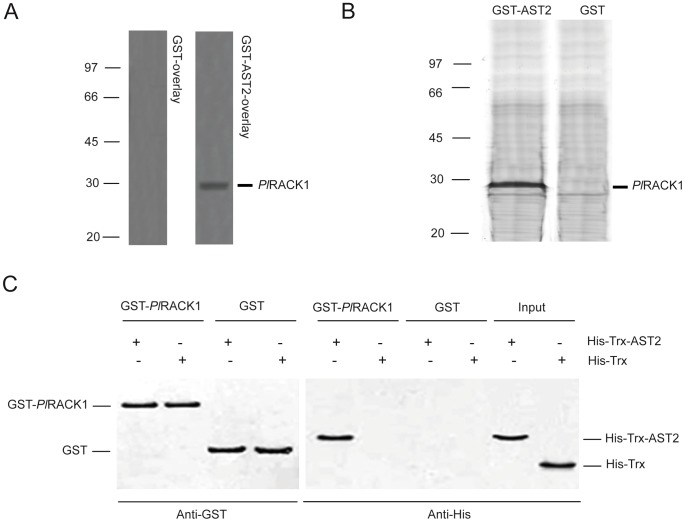
AST2 interacts with PlRACK1.A) PlRACK1 was identified as an AST2 binding protein using a far western assay with recombinant GST-AST2 or GST as a control. A HPT protein extract was subjected to SDS-PAGE, electroblotted to a PVDF membrane and overlayed with either GST (left) or GST-AST2 (right) alone and binding was detected using a GST antibody. B) The binding between recombinant AST2 with PlRACK1 was confirmed by a GST pull-down assay using GST-AST2 as the binding protein and proteins in a HPT cell lysate as bait. GST was used as a control in both assays. C) GST pull-down of His-Trx-AST2 by GST-PlRACK1. The bound proteins were analyzed by 12.5% SDS-PAGE. Bands corresponding to GST and GST-PlRACK1 were detected with an anti-GST antibody (lanes 1–4). The eluted material was also examined for the presence of AST2 with an anti-His antibody (lanes 5–8). Lanes 9 and 10 contain purified His-Trx-AST2 and HisTrx, respectively.